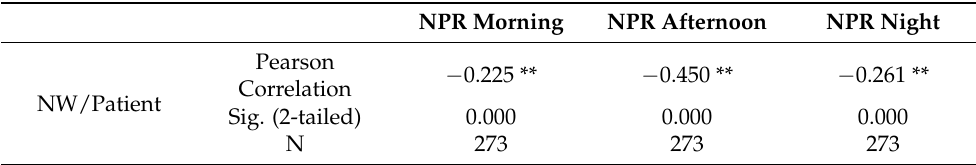
Table 6. Correlation of nursing workload (NW) per patient to the nurse/patient ratio